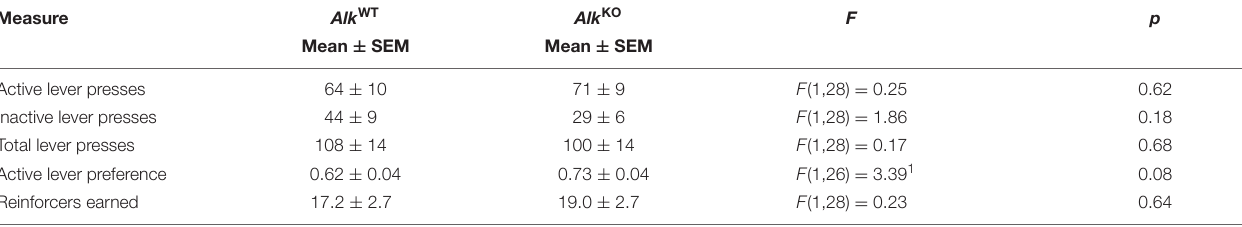
TABLE 1 | Operant self-administration measures in Alk WT vs. Alk KO mice during fixed ratio sessions.